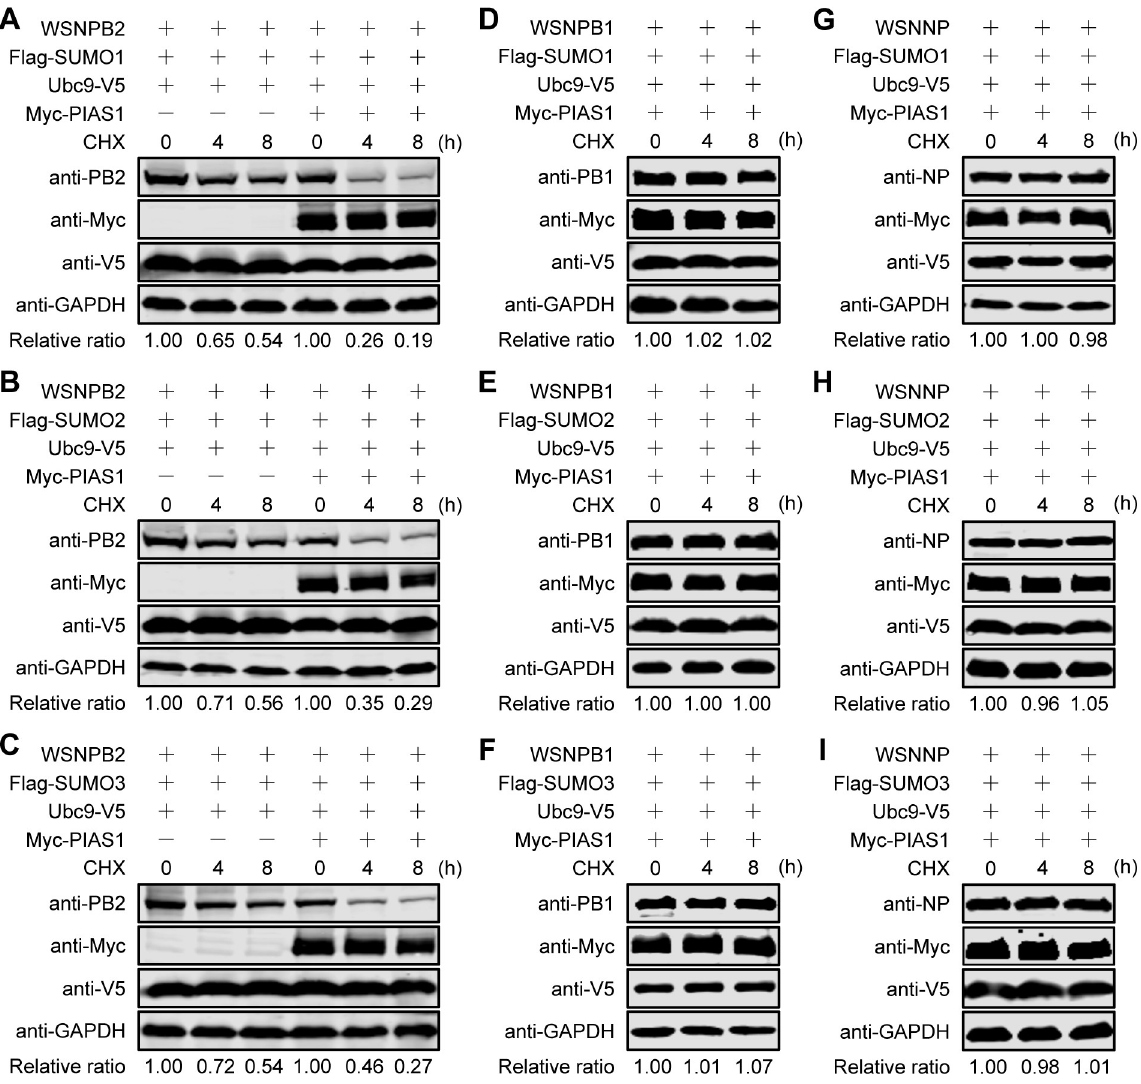
Fig 7. IAV PB2, PB1, and NP exhibit diverse stability in the presence of exogenously expressed SUMOylation components. (A-I) Stability of PB2, PB1 and NP in the presence of exogenous SUMOylation components. HEK293T cells were transfected with plasmids for the expression of WSNPB2, Flag-SUMO1/2/3, Ubc9-V5, along with/without Myc-PIAS1 (A-C), or transfected with plasmids for the expression of WSNPB1 (D-F) or WSNNP (G-I) in combination with Flag-SUMO1/2/3, Ubc9-V5, and Myc-PIAS1. At 36 h post-transfection, the cells were treated with CHX. At the indicated timepoints, cell lysates were subjected to western blotting. Data are representative of three independent experiments (A-I). The band intensities of PB2, PB1, and NP, quantified by using ImageJ software, were normalized to GAPDH and are expressed as relative ratios compared with untreated cells at 0